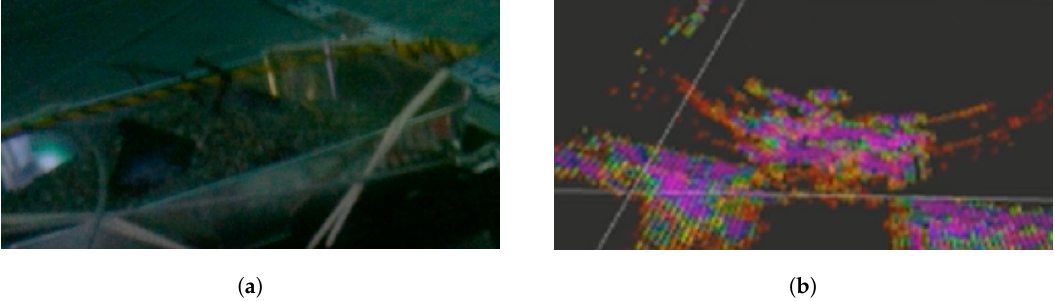
Figure 15. Comparison of an on-board image from the ROV of simulated debris ( a ) vs. one 2D slice of the 3D reconstruction from the sonar data ( b